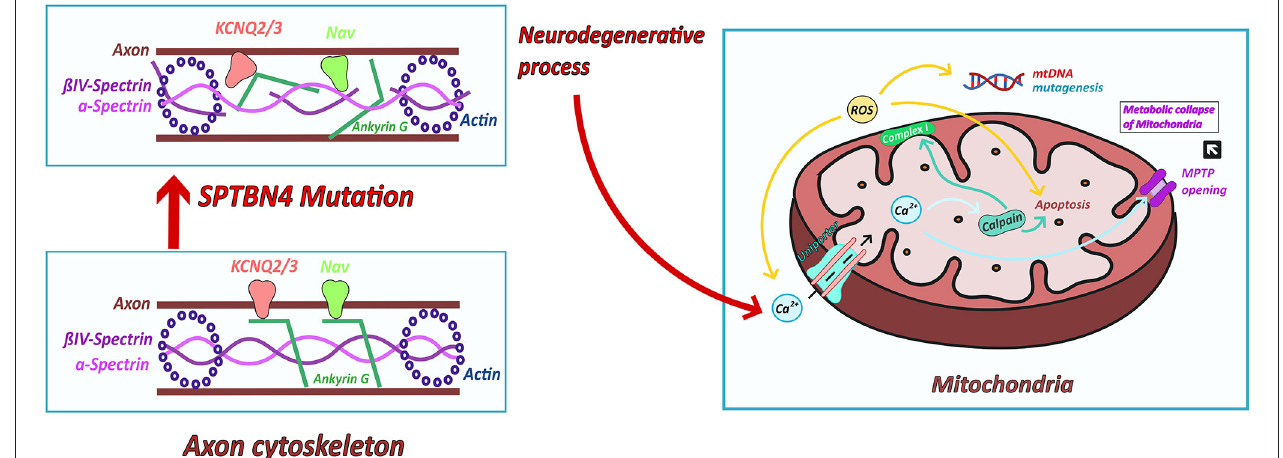
FIGURE 4 | Possible links between ßIV-spectrin deficiency and mitochondrial dysfunction. ßIV-spectrin deficiency leads to a destabilization of the cytoskeleton and thus to misclustering of ion channels, like NaV sodium and KCNQ potassium channels. The resulting neurodegenerative process could cause an altered calcium homeostasis ( 23). Increased calcium concentration enter the mitochondria via ruthenium red sensitive Ca 2 + uniporter inducing the activation of calpain. Calpain induces impaired respiratory chain activity ( 23) and cell death (24, 25). Furthermore, increased calcium influx leads to opening of MPTP and thus swollen mitochondria and metabolic collapse of the mitochondria. Complex I produces ROS which leads to increasing calcium concentration and cell death. ROS are produced in complex I (22). Increasing oxidative stress leads to cell stress and to liberation of calcium from the ER. ROS could then induce mtDNA mutagenesis and neuronal cell death